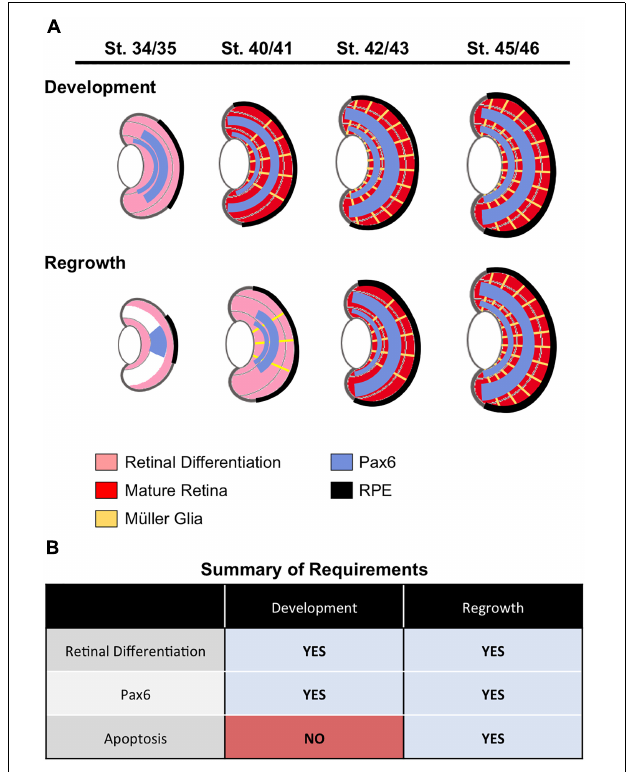
FIGURE 8 | Summary. (A) A summary of retinal cell differentiation during regrowth as compared to development. The stages correspond to 1, 2, 3, and 4 days post surgery (dps), respectively. (B) Summary of required processes identified in eye development and